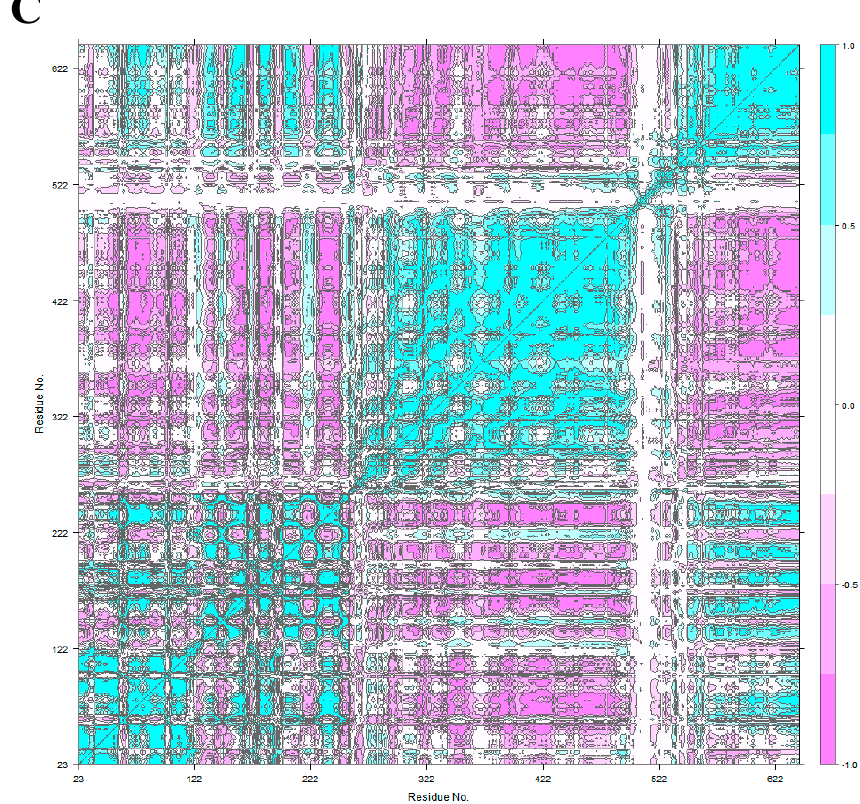
Figure 4. Cross-correlation analysis. ( A ) unbound HER2; ( B ) HER2 at F0178:HER2, and ( C ) HER2 at scFv:HER2.